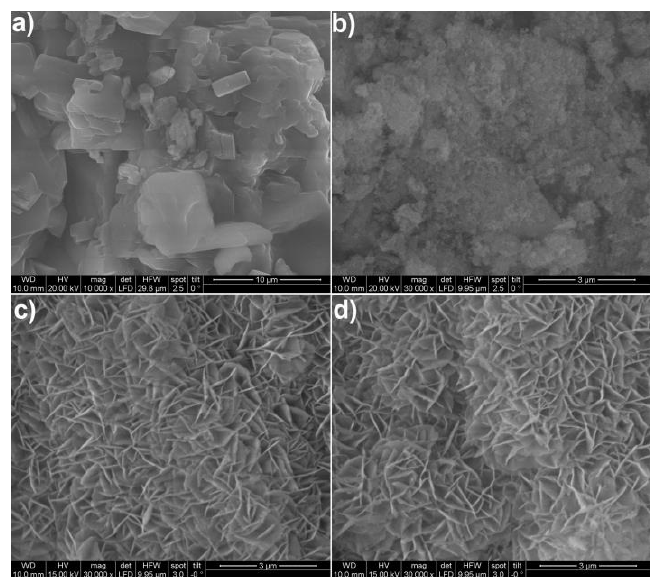
Figure 6. SEM images of ( a ) MgC 2 O 4 ∙2H 2 O, ( b ) calcined MgC 2 O 4 ∙2H 2 O ( C 2 O 4 -1 ), ( c ) calcined MgC 2 O 4 ∙2H 2 O, rehydrated for 24 h in liquid water ( C 2 O 4 -3 ), ( d ) material from image c after calcination ( C 2 O 4 -4 ).